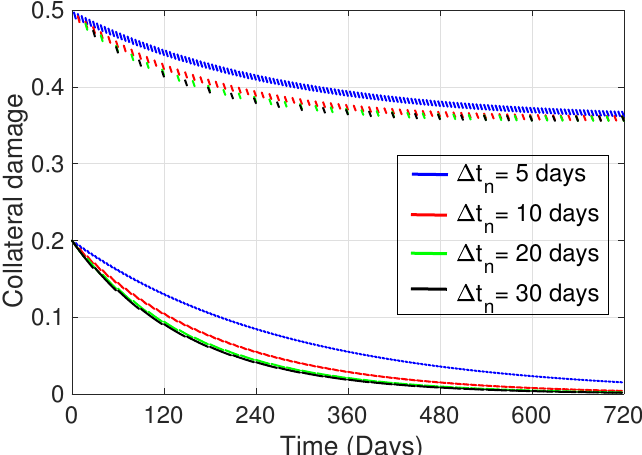
Figure 8. The figure shows the collateral damage of the ecosystem due to misuse of ITNs as fishing gear for different no-fishing timeframes ∆ t n days. The blue, red, green, and black lines correspond to average no-fishing timeframes of 5, 10, 20, and 30 days, respectively. All other parameter values used are as in Figure